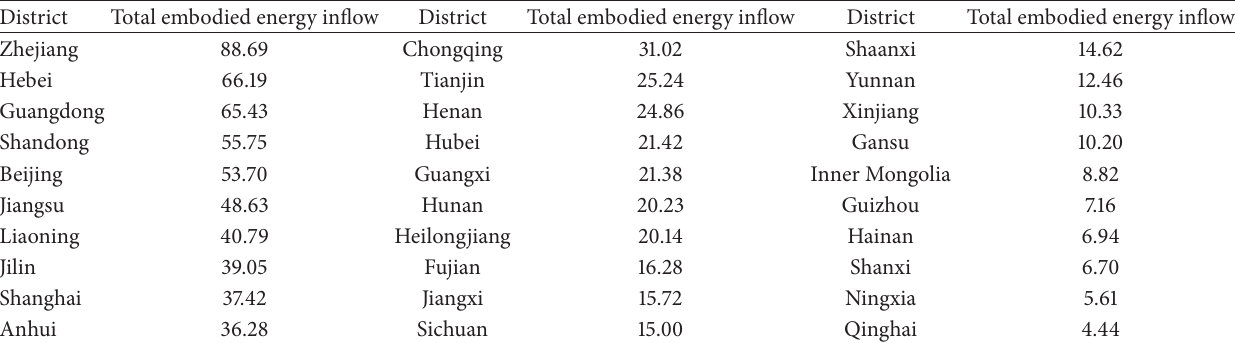
Table 6: Total embodied energy inflows via interprovincial trade for each province in 2007 (in millions of tons of standard coal). District Total embodied energy inflow District Total embodied energy inflow